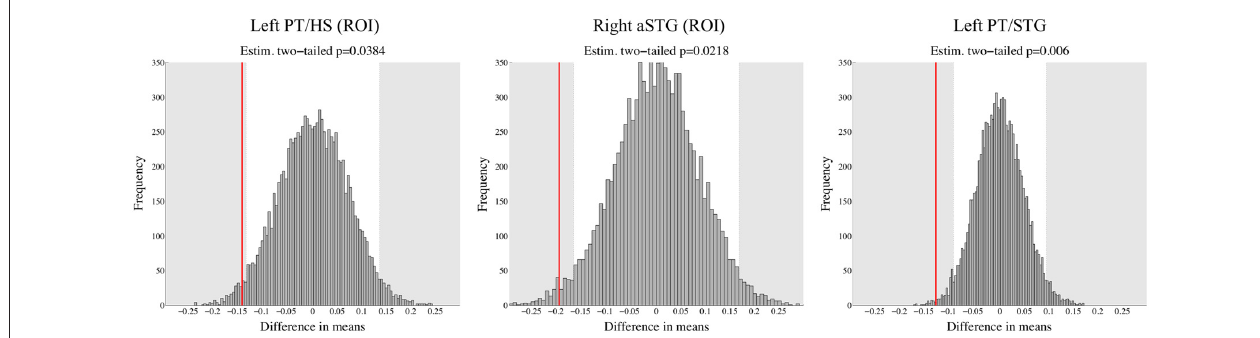
FIGURE 4 | Results obtained using bootstrap analysis based on percent signal change data in two ROIs from Blau et al. (2010) and in the left PT/STG cluster from the whole brain analysis of FHD+ and FHD − children. Red line represents the actual observed value of difference in means between TR and DYS children, whereas shaded gray areas depict significant differences (two-tailed p < 0.05). DYS compared to TR showed higher brain response to congruent letter-sound (LS) pairs in left PT/HS and in left PT/STG as well as higher brain response to speech sounds in right anterior STG